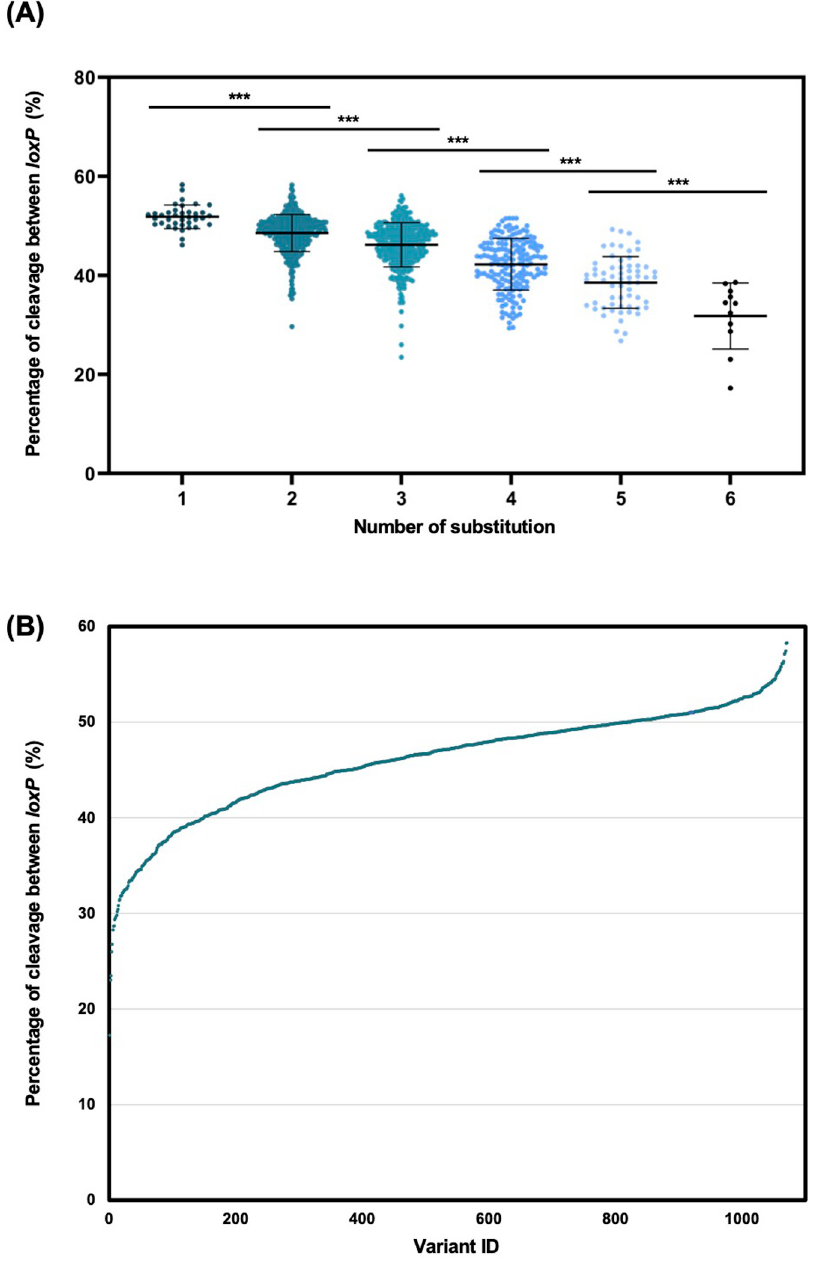
Fig 5. Illumina sequencing data analysis of the loxP variants. (A) Cleavage rate of all loxP variants is classified according to the number of base substitutions. A significant difference was found between each number of substitutions. ��� P < 0.001, two-tailed t -test. (B) Distribution of all loxP variants. The vertical axis indicates the cleavage rate between loxP sequences. loxP variants with reduced recognition rate by Cre were listed in order of the cleavage rate between loxP sequences. There was some overlap between the